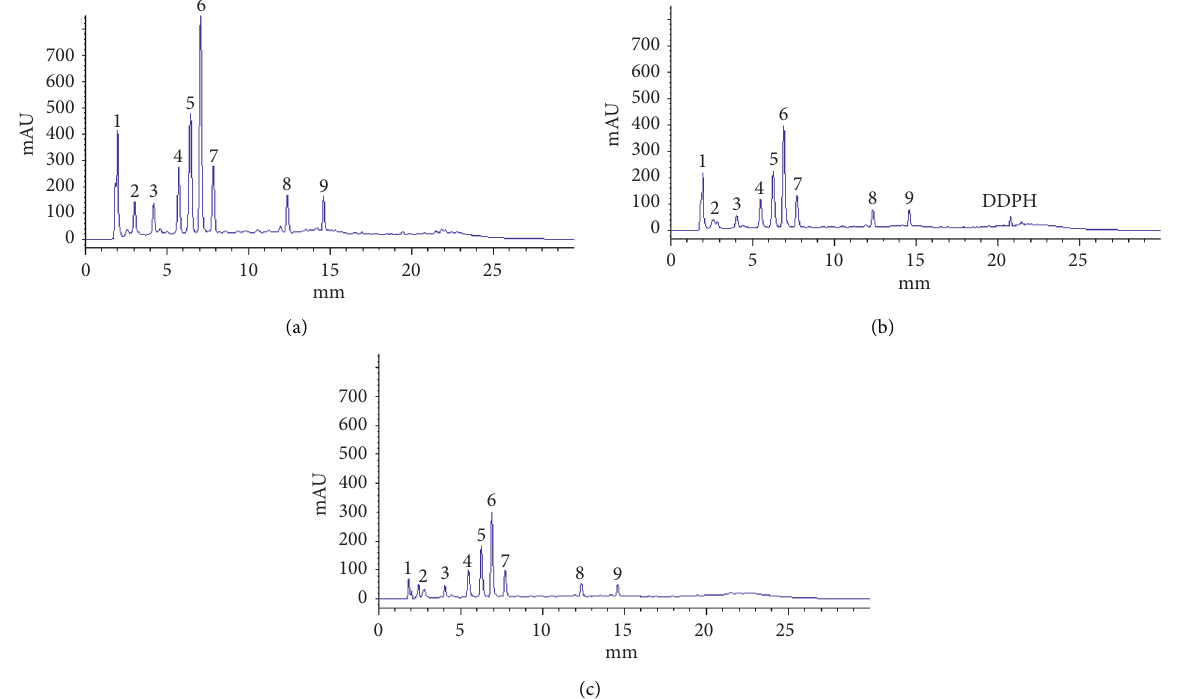
Figure 5: Chromatogram of antioxidant components in EAE (4mg/mL) screened by HPLC. (a) Chromatogram of the sample without any added reagent. (b) Chromatogram of the sample with added DPPH. (c) Chromatogram of the sample with added hydroxyl radical.